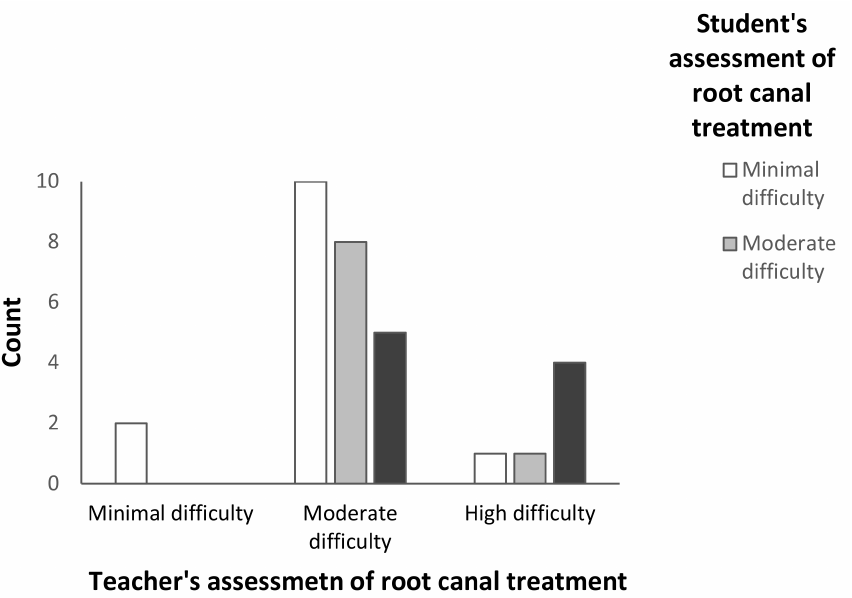
Figure 2. The students’ and the teacher’s assessments of the difficulty of root canal treatments. Forms assessing the success rate of the RCT were returned filled in concerning 88% of the cases. Complications occurred in 45% of the cases. In 69% of the cases where complications were seen, the assessments by the student and the supervisor